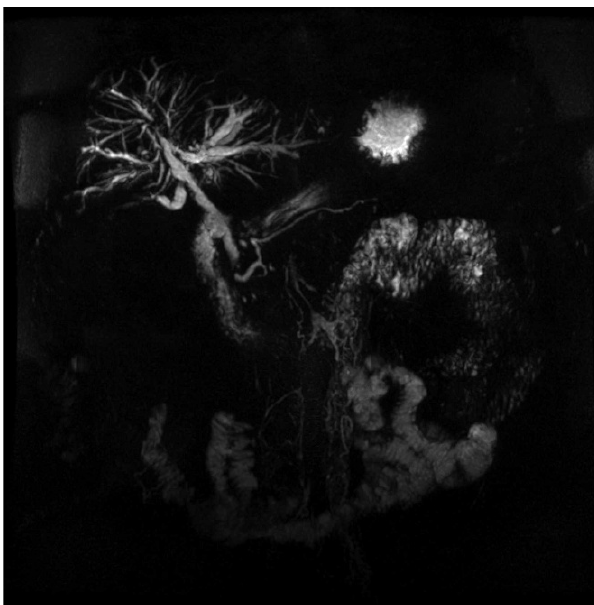
Figure 1 - Cholangio-NMR showing intrahepatic bile-duct strictures that are consistent with a diagnosis